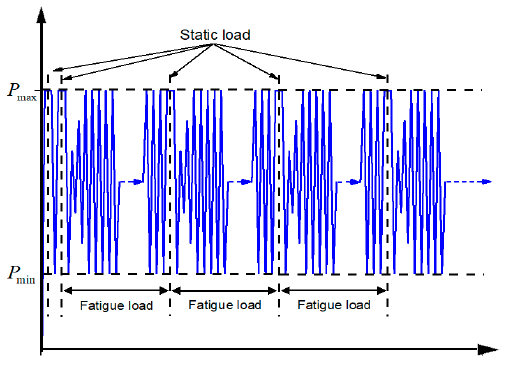
Figure 5. Failure mode of CFRP tendons.